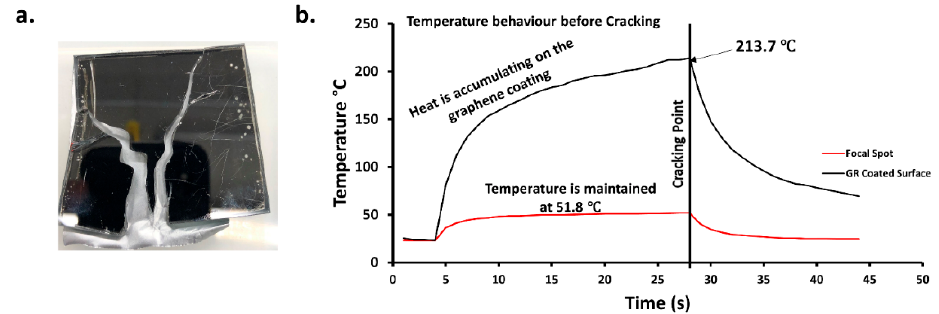
Figure 9. Medium GC sample facing the cell showing ( a ) the breakage photograph and ( b ) the